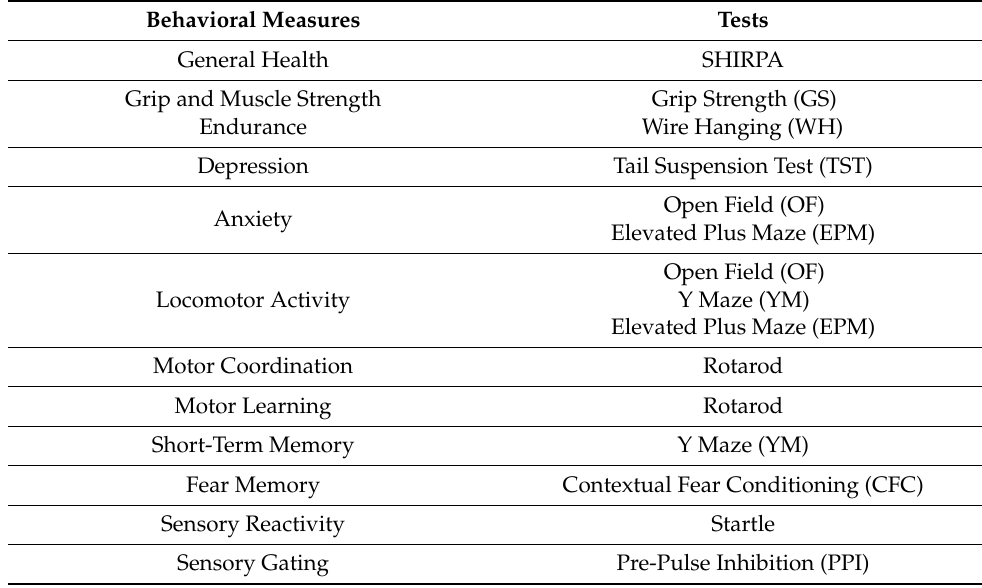
Table 1. Behavioral